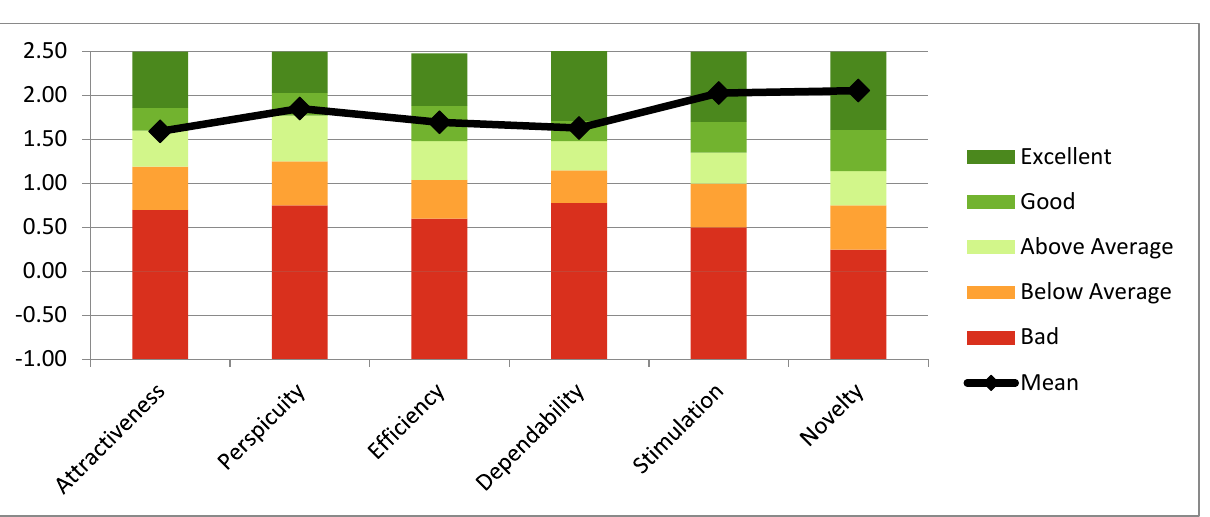
Figure 9. Comparison between means of each UEQ scale and values from a benchmark dataset.